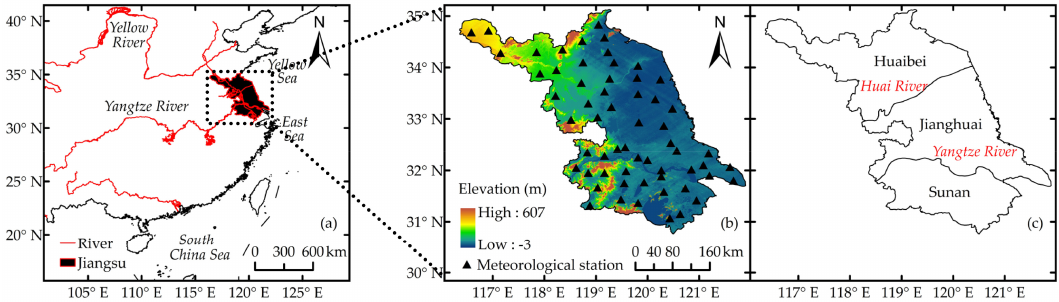
Figure 1. Map showing Jiangsu province: ( a ) location; ( b ) meteorological station ( ▲ ) and elevation; ( c ) sub ‐ regions and rivers.